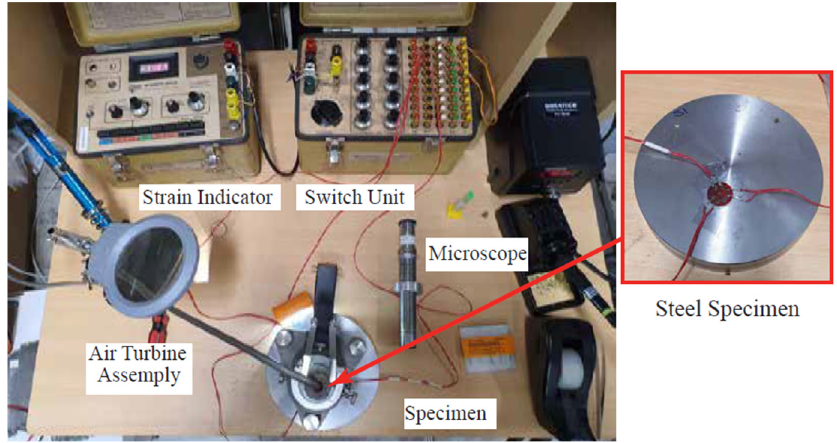
Figure 5. Setup of the hole-drilling